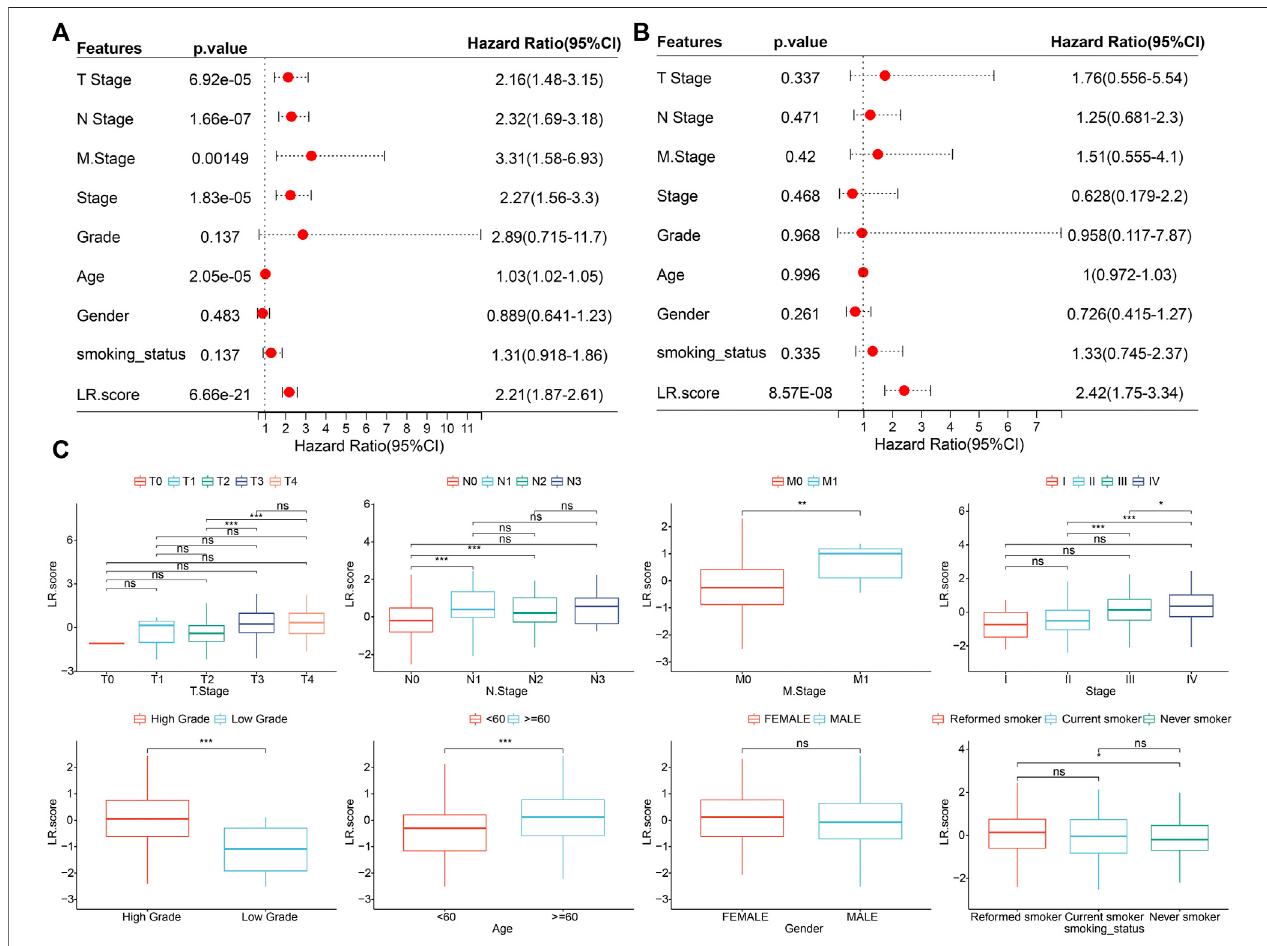
FIGURE7| AssociationsbetweenLR.scoreand clinicalvariables (A) .UnivariateCoxregressionanalysisofoverallsurvivalwithclinicalfactors ofLR.score,patient age, gender, stage_T, stage_N, stage_M, stage, grade, smoking status in the TCGA cohort. (B) . Multivariate Cox regression analysis of overall survival with clinical factors of LR. score, patient age, gender, stage_T, stage_N, stage_M, stage, grade, smoking status in the TCGAcohort. (C) . Distributions ofthe LR. score in Tstage, N stage, M stage, stage, grade, age, gender, and smoking status in TCGA cohort. ns, p > 0.05; * p < 0.05; ** p < 0.01; *** p < 0.001. Wilcoxon rank-sum test.